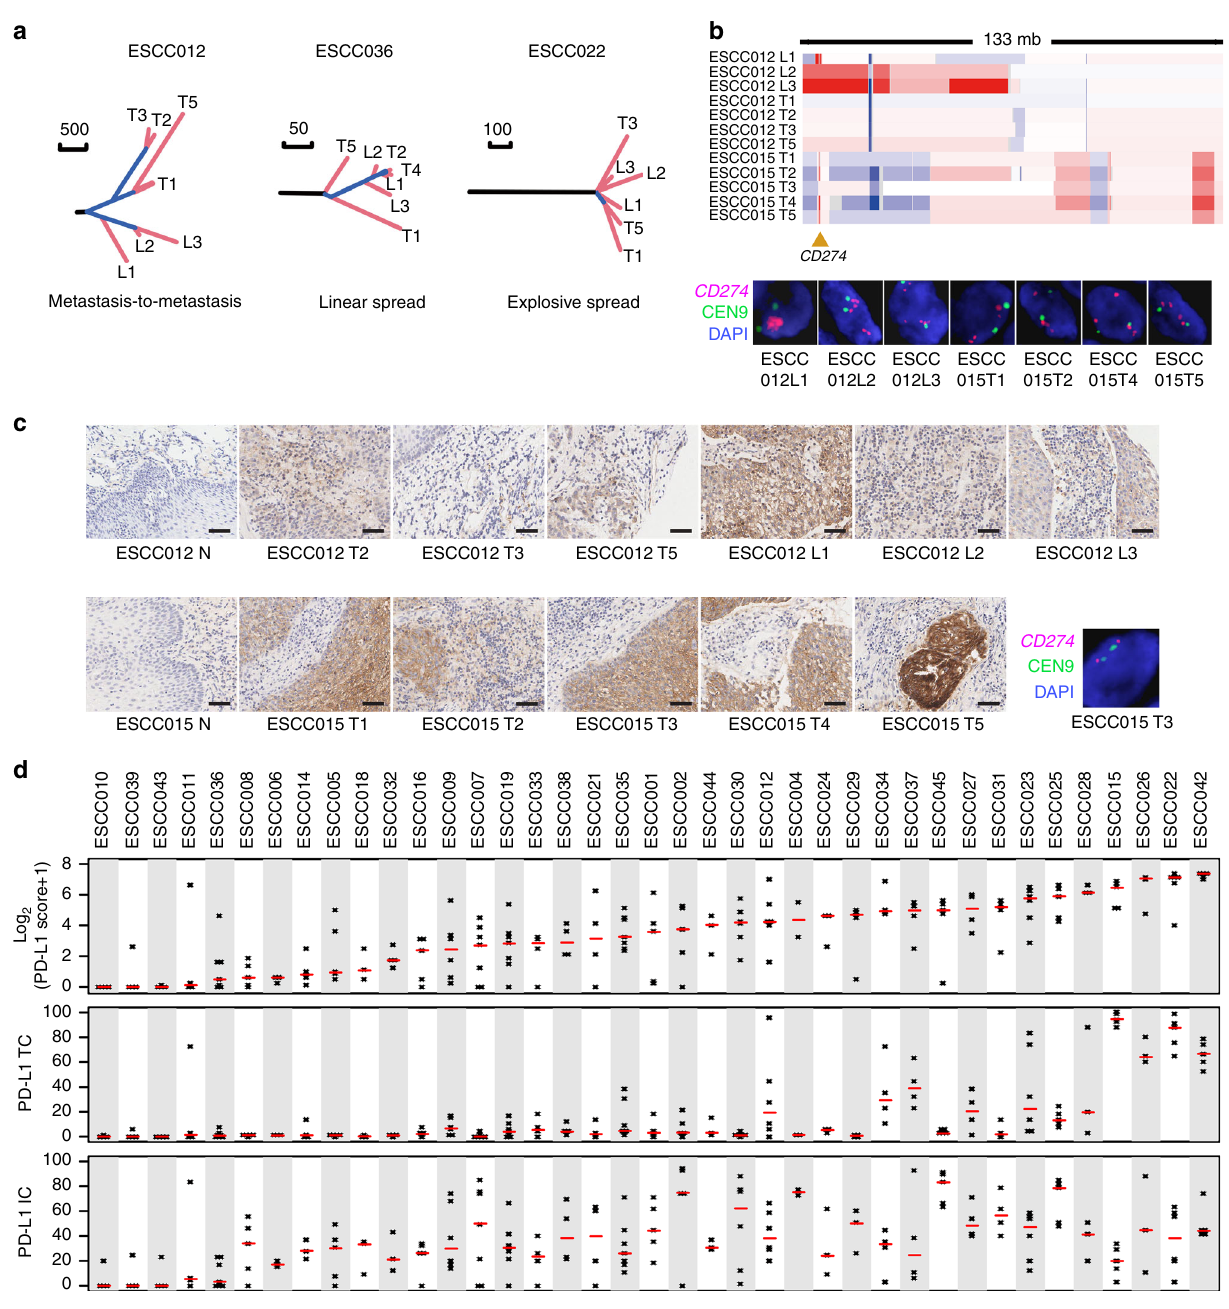
Fig. 6 ITH of ampli fi cation and protein expression of CD274 (PD-L1) in ESCC. a Representative phylogeny for metastasis patterns of ESCC. b ITH of ampli fi cation in case ESCC012 and ESCC015. The bottom panel displays FISH validation of CD274 ampli fi cations. c IHC staining of PD-L1 on samples from patients ESCC012 and ESCC015. Right bottom shows the absence of CD274 ampli fi cation using FISH analysis in ESCC015 T3. Scale bar: 50 μ m. d PD-L1 protein expression in TC, IC, and tumor